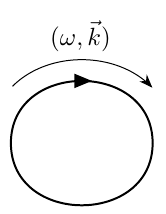
Figure 9 . One-loop vacuum